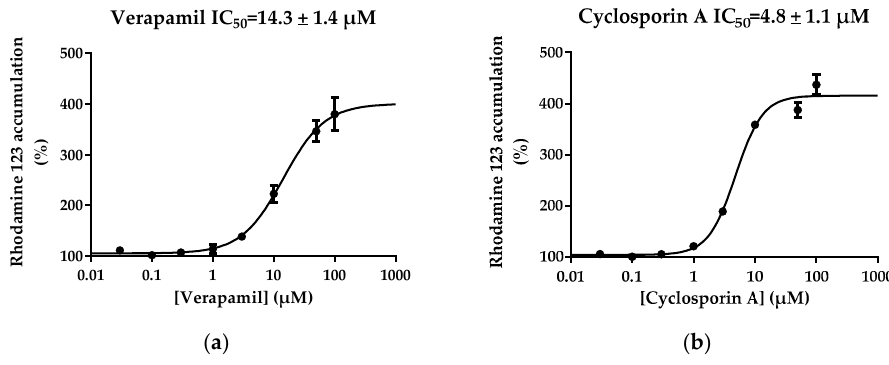
Figure 3. Concentration-dependent effects of verapamil and cyclosporin A on rhodamine 123 accumulation in MCF7R cells. Cells were exposed to 5.25 μ M rhodamine 123 for 30 min at 37 °C in the absence or presence of various concentrations of ( a ) verapamil or ( b ) cyclosporin A. After washing, rhodamine 123 accumulation was quantified by spectrofluorimetry. Data are expressed as % of rhodamine 123 levels found in control MCF7R cells not exposed to verapamil or cyclosporin A, arbitrarily set at 100% and are the means ± SEM of three independent experiments. IC 50 values for P-gp activity, which correspond to EC 50 values for increase of rhodamine 123 accumulation, are indicated at the top of the graphs.